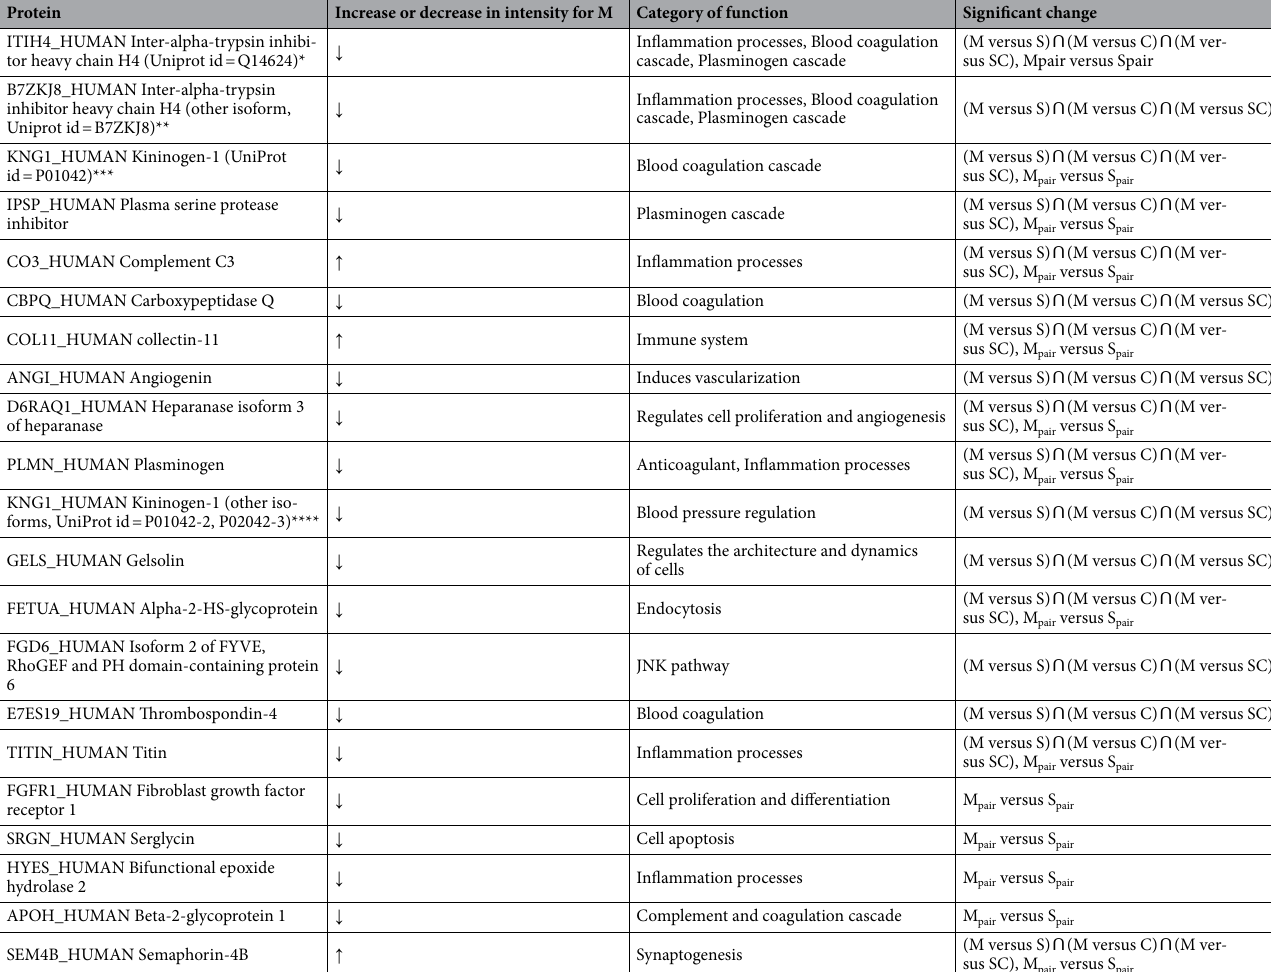
(M versus S) ∩ (M versus C) ∩ (M versus SC) with the most significant change (according to M versus S q value) in protein intensity quantification values, with additional 5 remaining proteins with a significant change in protein intensity quantification values from comparison of M pair versus S pair . *MaxQuant search id